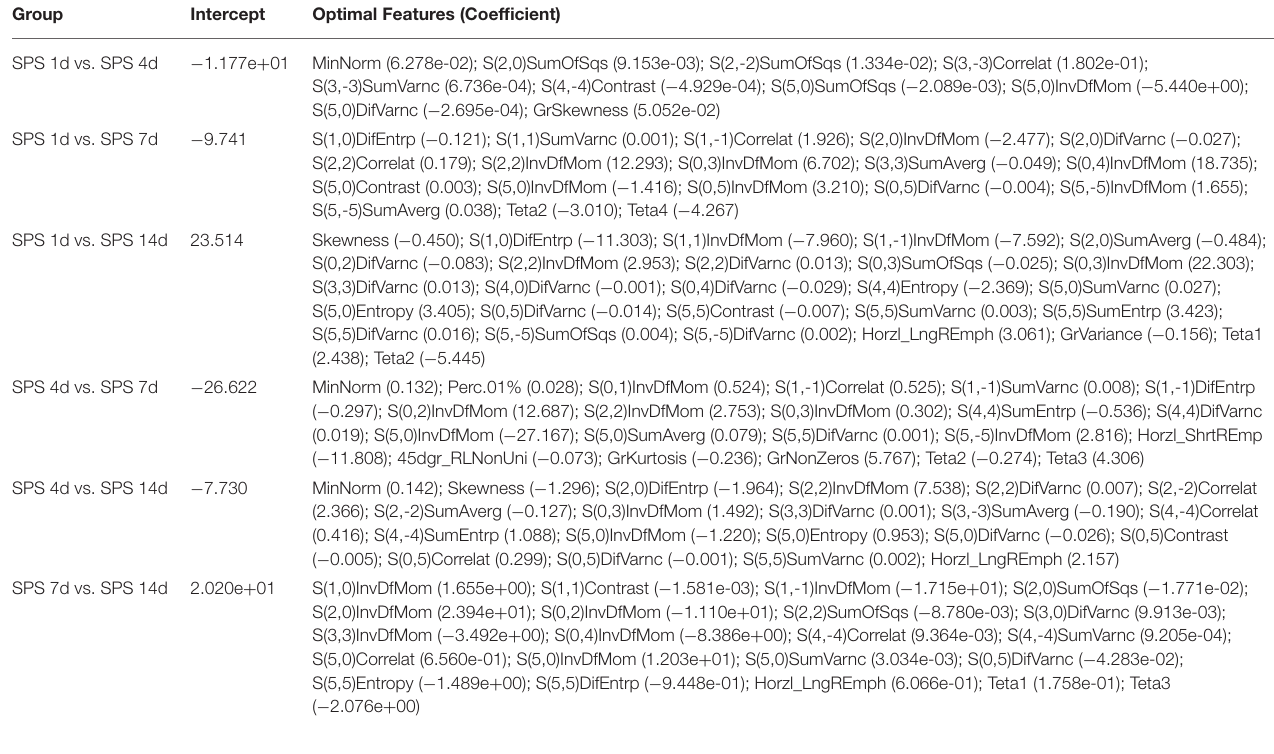
TABLE 3 | Optimal mPFC features after dimensionality reduction among four SPS groups via LASSO regression. Group